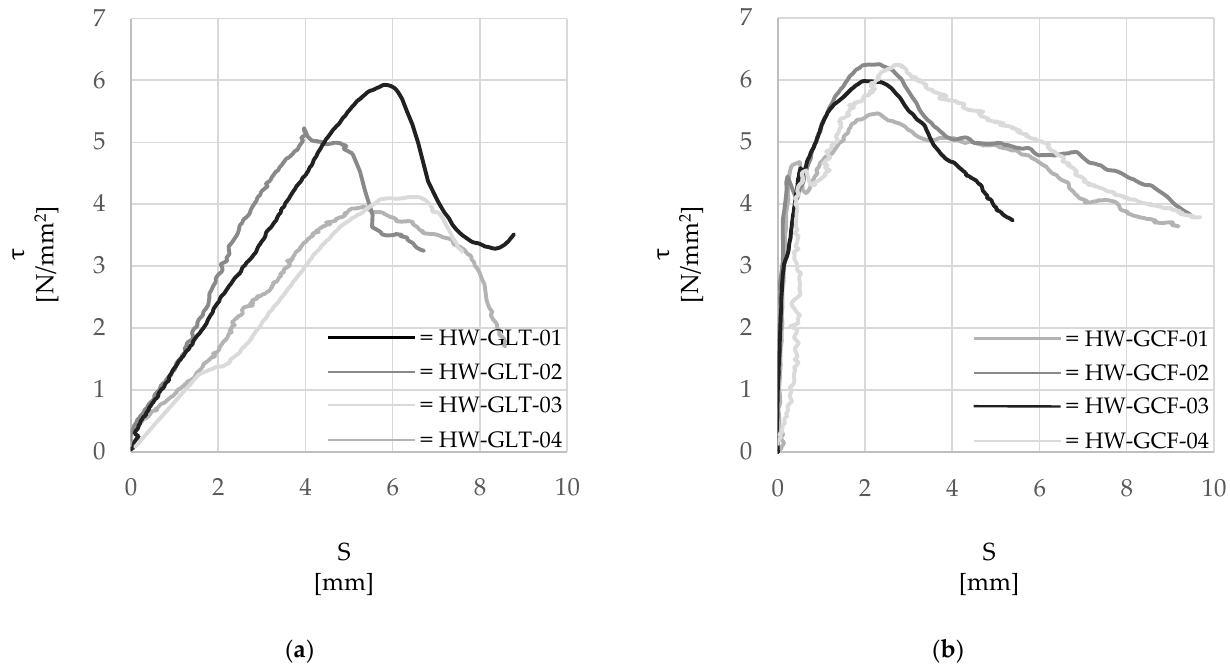
Figure 5. Experimental τ-slip (τ-S) response curves. ( a ) ‘HW-GLT’ system; ( b ) ‘HW-GCF’ system. The average bond stress ‘τ’ is defined according to Equation (1). The slip of the rein- forcement ( S ) relative to the mortar is determined by measuring the relative displacement between a marker placed on the mortar cube and a marker placed along the unbonded